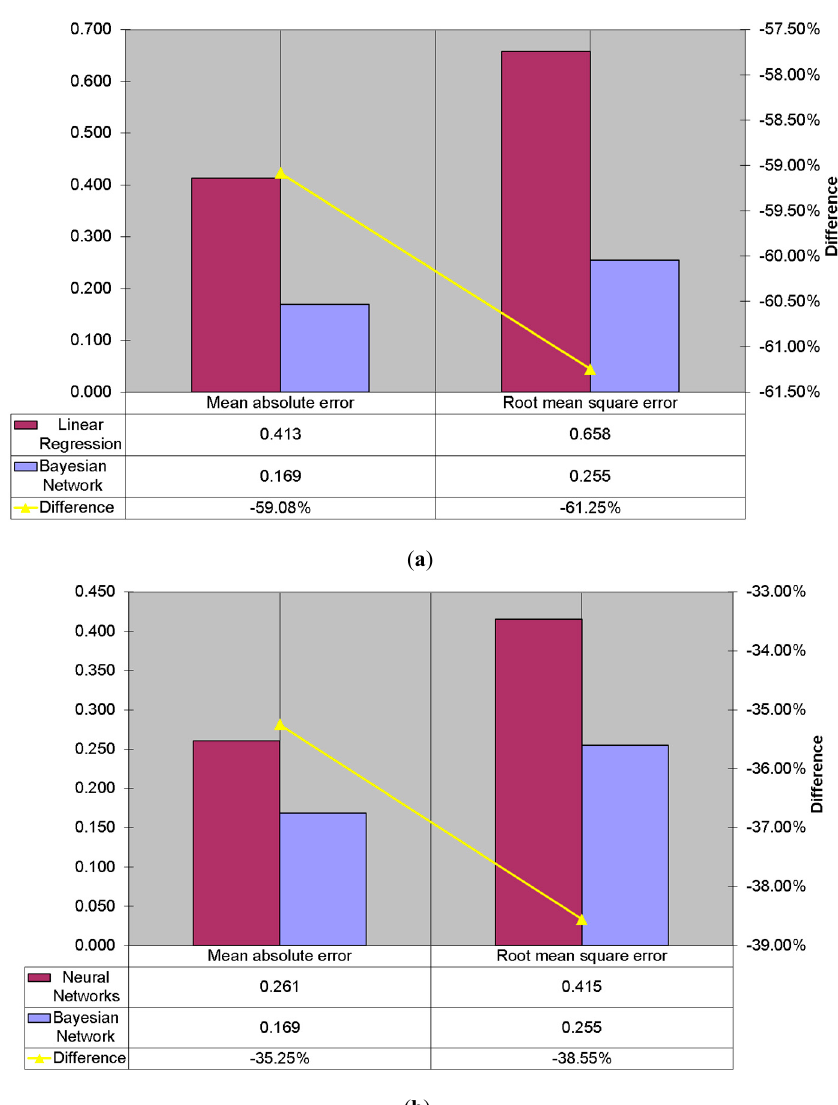
Figure 14. Comparing the performance of the proposed Bayesian method against Linear Regression analysis ( a ) and Neural Networks ( b ).